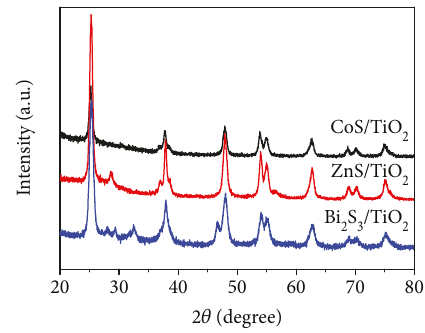
Figure 1: XRD patterns of CoS/TiO